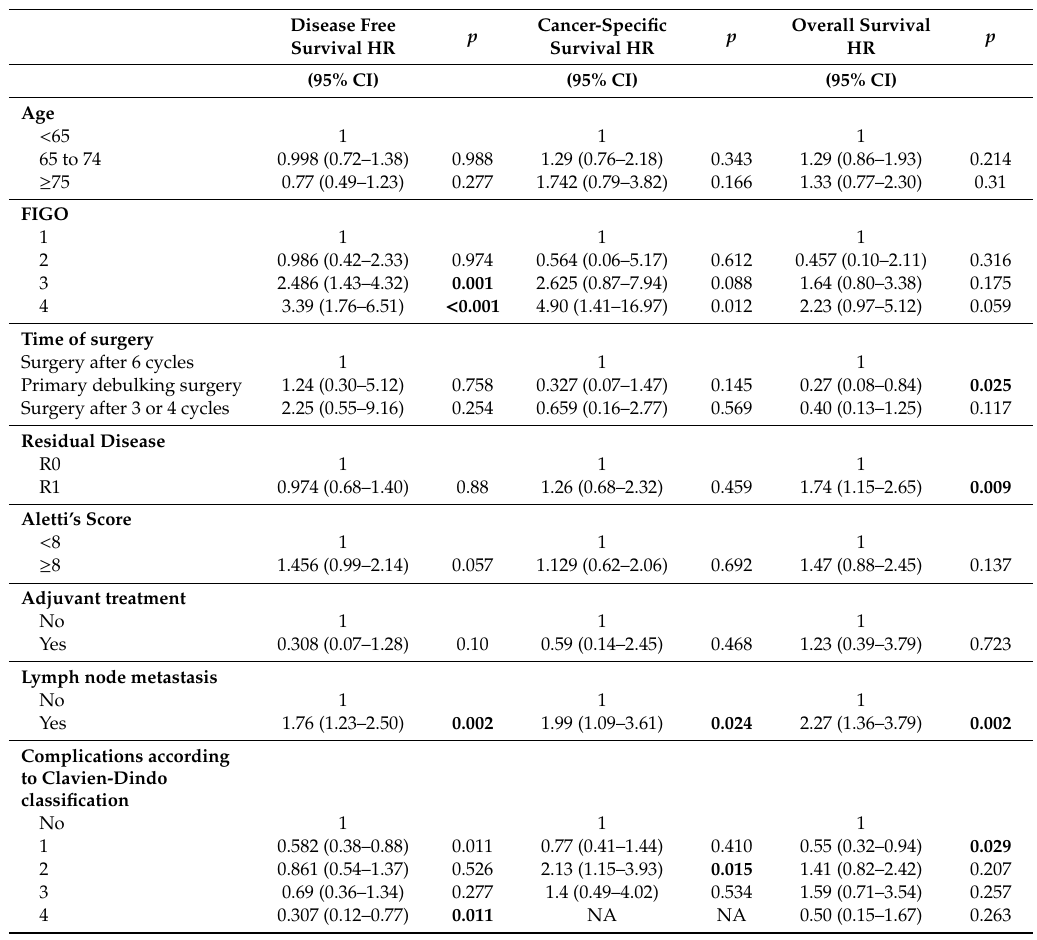
Table 4. Three-year disease-free survival, cancer-specific survival and overall survival rates (multivariate